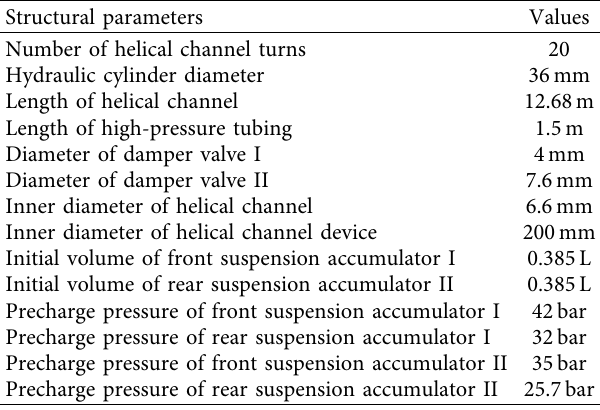
Table 2: Hydro-pneumatic ISD suspension